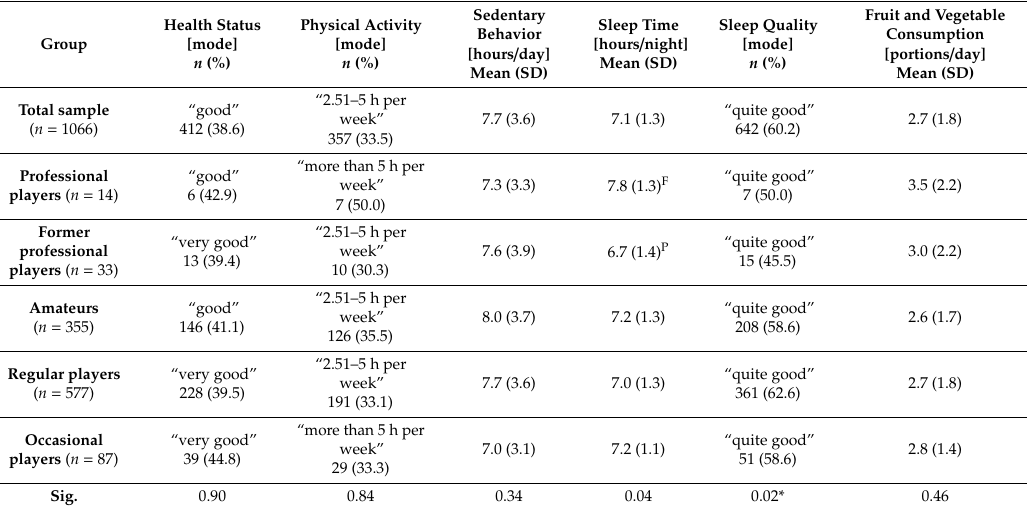
Figure 1. Sports activities of sample participants. Multiple responses were possible (n = 1100). Table 2. Data on health behavior of the sample.